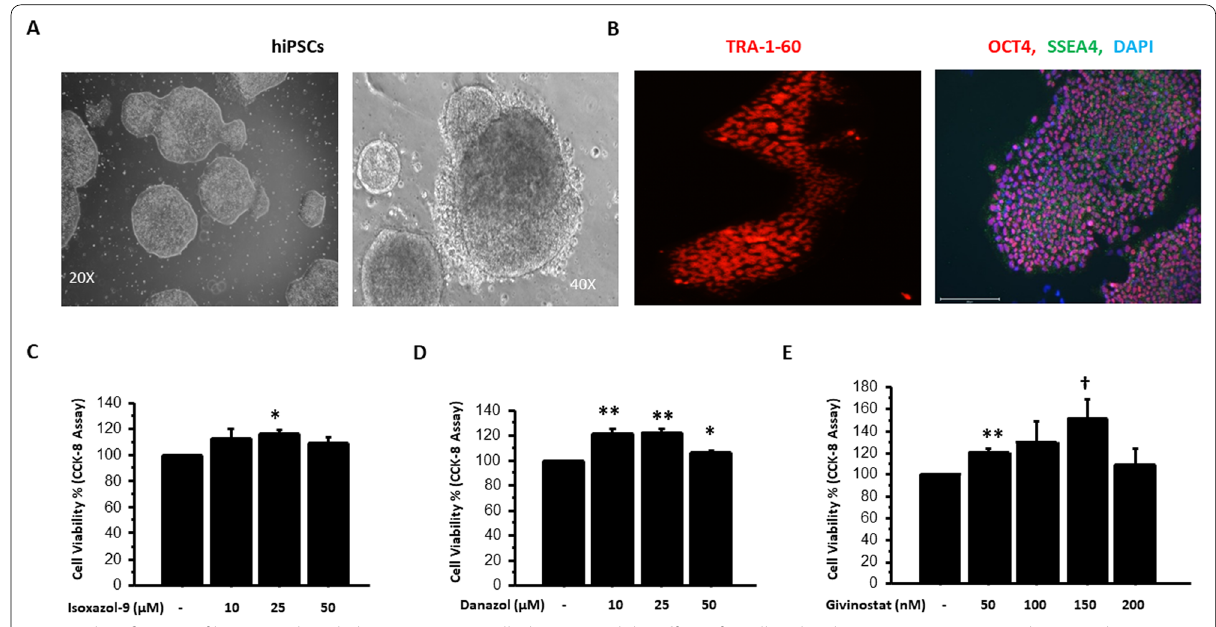
Fig. 1 Identification of human induced pluripotent stem cells (hiPSCs) and the effect of small molecules treatment on in vitro hiPSCs culture: Representative microscopic picture of hiPSCs (20X and 40X, A ) were identified by immunostaining markers TRA-1-60 (Red), OCT4 (Red) and SSEA4 (green) with DAPI (blue for nuclei, B ). hiPSCs viability were assessed by CCK-8 after treatment with Isoxazole (ISX-9, 10–50 µM, C ), Danazol (DAN, 10–50 µM, D ) and Givinostat (GIV, 10–200 nM, E ). Higher cell viability (CCK8 kit) was observed with using ISX9 (25 µM), DAN (25 µM) and GIV (150 nM). Values are mean SE; n 6; † P- value < 0.05, * P- value 0.01, ** P- value 0.001, # P- value 0.0001 are ± = = = =